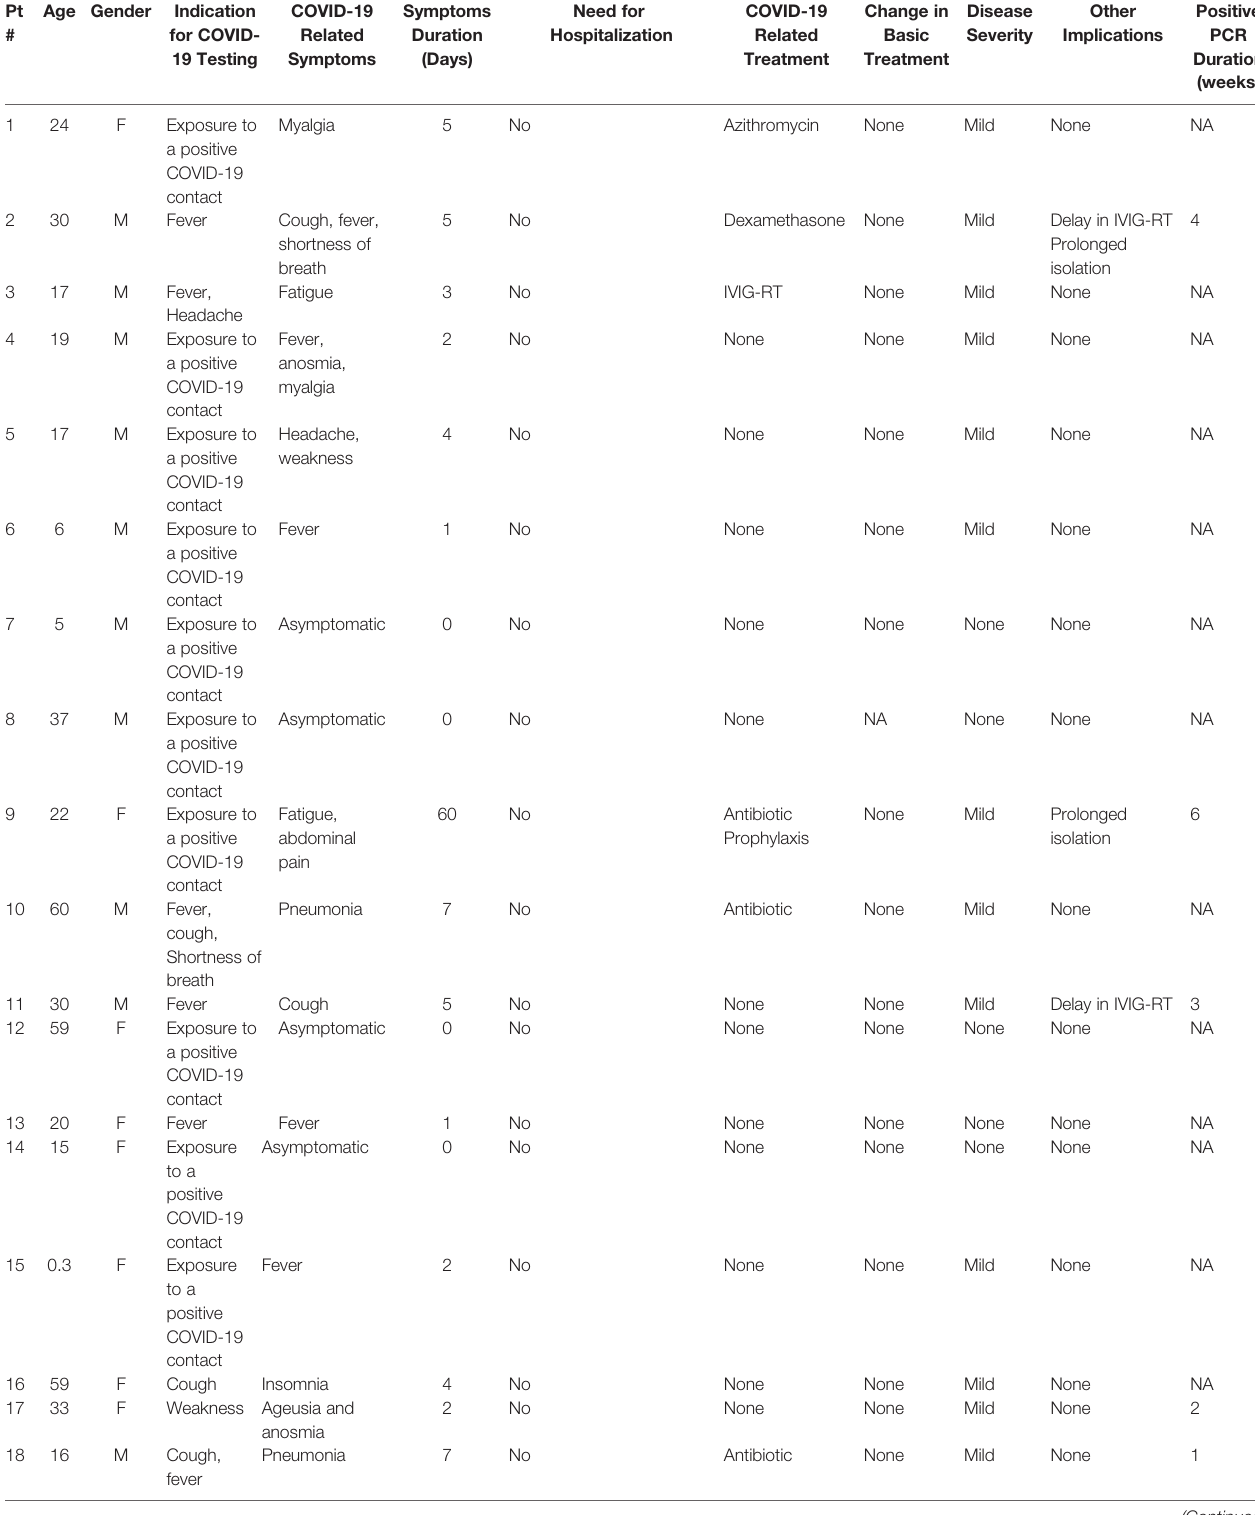
TABLE 2 | Clinical data and disease course of SARS-CoV-2 positive test and COVID-19 infection in 20 patients with Primary immunode fi ciency. Pt Age Gender Indication # for